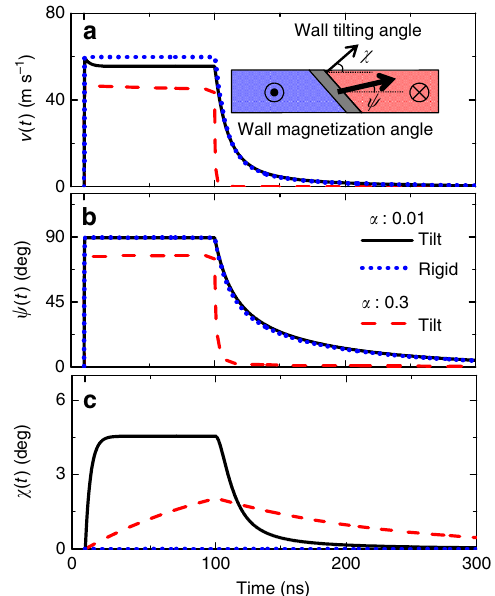
Figure 2 | One-dimensional model calculations of domain wall (DW) velocity for wires without pinning. ( a – c ) Instantaneous DW velocity v ( t ) ( a ), wall magnetization angle c ð t Þ ( b ) and wall tilting angle w ( t ) ( c ) for a fixed current density ( J ¼ 0.5 (cid:3) 10 8 Acm (cid:2) 2 ) flowing through the heavy metal layer. The current pulse length is ( t P ) is 100ns. Definition of the angles c ð t Þ and w ( t ) are illustrated in the inset of a . Numerical results for the rigid wall, that is, w ( t ) ¼ 0, with low damping ( a ¼ 0.01) are shown by the blue dotted line whereas results for the tilted walls ( w ( t ) a 0) are shown by the black solid ( a ¼ 0.01) and red dashed ( a ¼ 0.3) lines. Parameters used: saturation magnetization M S ¼ 1,100emucm (cid:2) 3 , magnetic anisotropy energy K EFF ¼ 3.2 (cid:3) 10 6 ergcm (cid:2) 3 , wall width parameter D ¼ ffiffiffiffiffiffiffiffiffiffiffiffiffiffi A = K EFF p 6 : 8nm (exchange constant A ¼ 1.5 (cid:3) 10 (cid:2) 6 erg cm (cid:2) 1 ), spin Hall angle y SH ¼ (cid:2) 0.21, DM exchange constant D ¼ 0.24ergcm (cid:2) 2 , Gilbert a ¼ 0.05 and wire width w ¼ 5 m m. NATURE COMMUNICATIONS|7:13533|DOI: